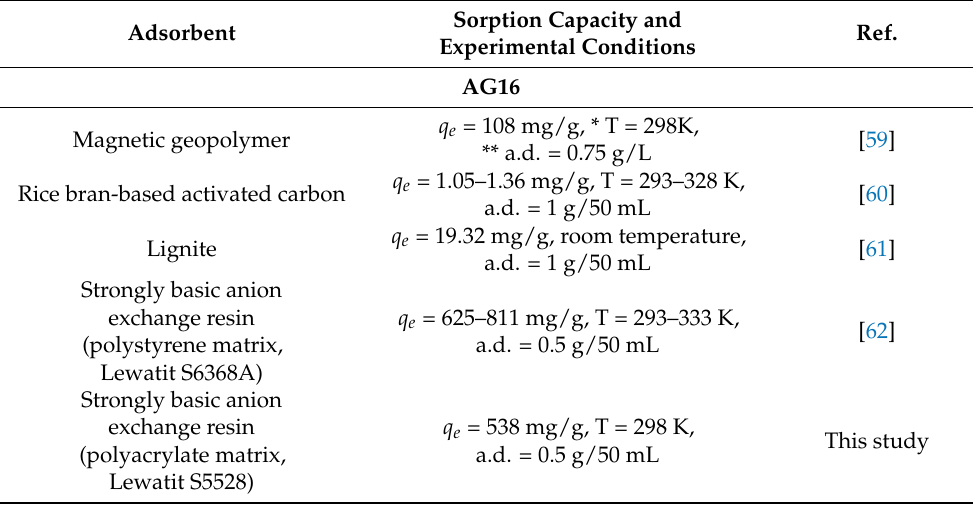
Table 2. Comparison of the sorption properties of various adsorbents for AG16, phenol and heavy metal ions uptake based on a literature